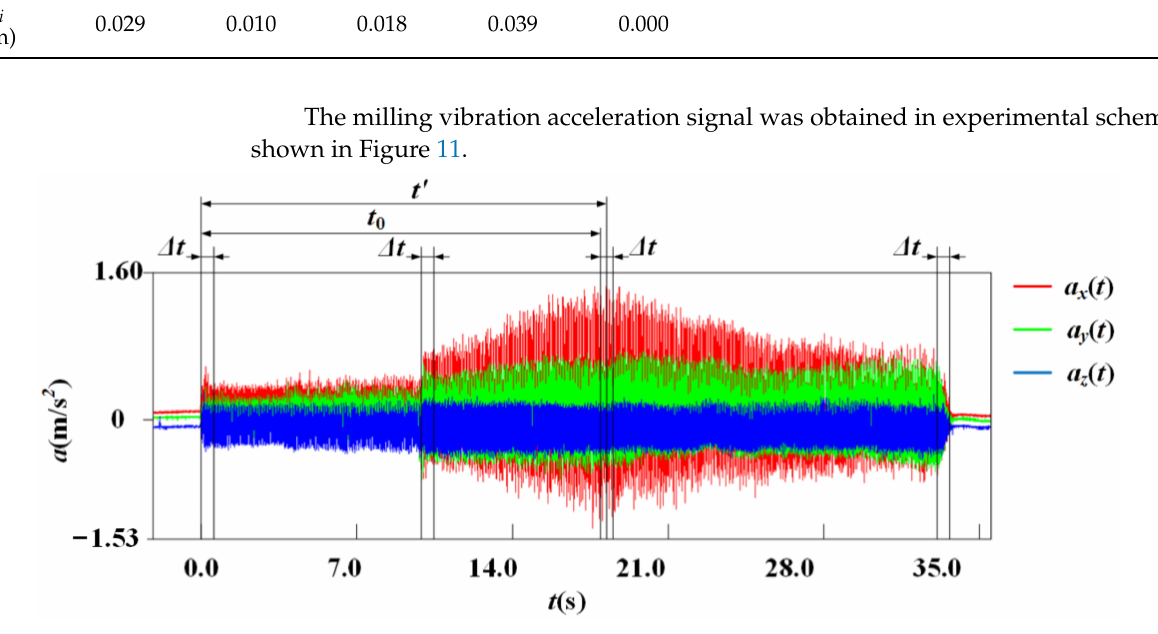
Figure 11. Milling vibration acceleration signal of the scheme